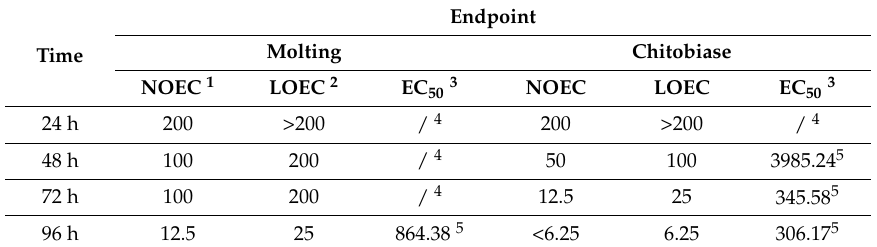
Table 2. Summary of the effect concentrations ( µ g/L) of carbamazepine for different endpoints in juvenile Daphnia similis during acute